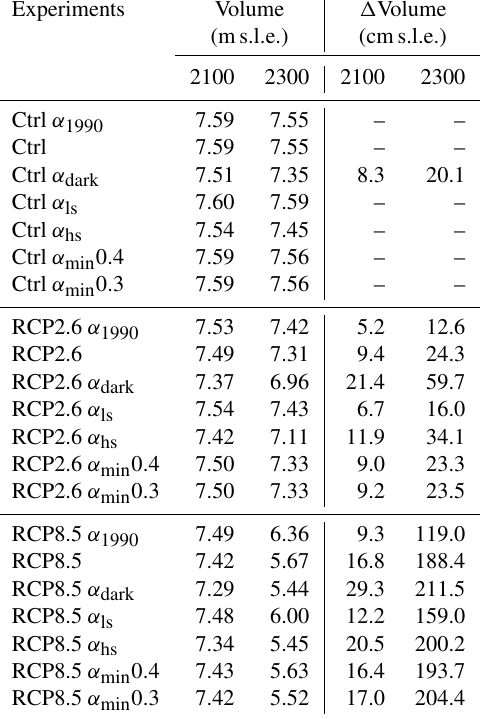
Table 2. Sea-level-relevant volume (in metres of sea level rise equivalent) and mass loss (in centimetres of sea level rise equiv- alent). All values are relative to the respective control simulation. Only α dark simulations are given in absolute values, since the Ctrl α dark is an extreme scenario which does not qualify as a control